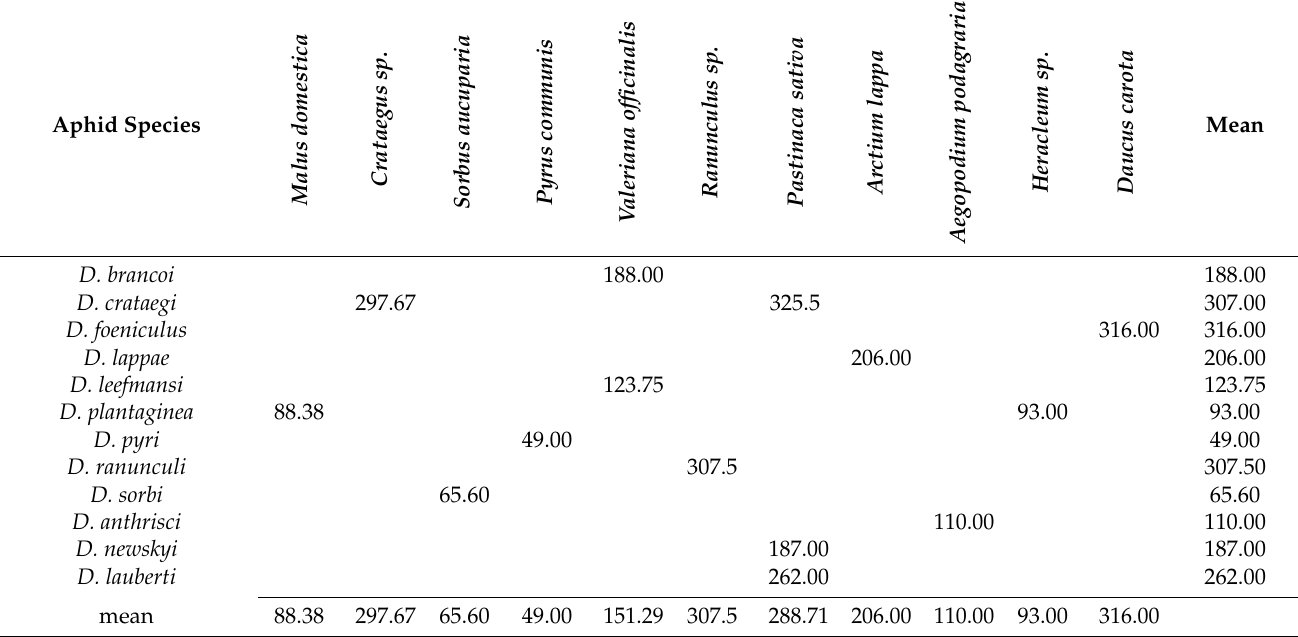
316.00 The beta diversity revealed by heatmaps was most informative in the case of the analysis of OTUs with the Bray method, where the clusters A and B, together with single (Figure 9), except of sample 8d-21 collected from the secondary host. The remaining clusters consisted of samples from either the primary host (few) or secondary host